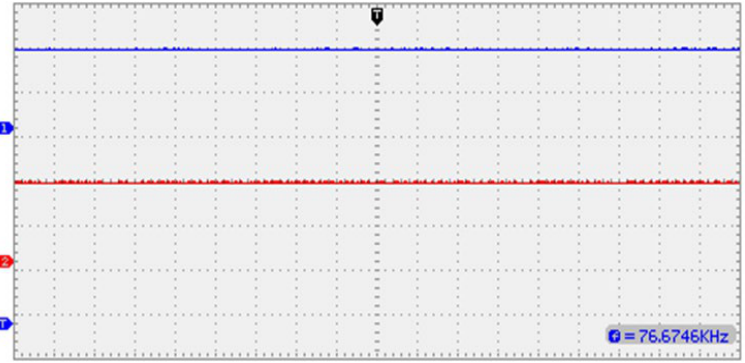
Figure 12. Capacitor voltages V CO1 ( top ) and V CO2 ( bottom ) (vertical scale 200 V/div).